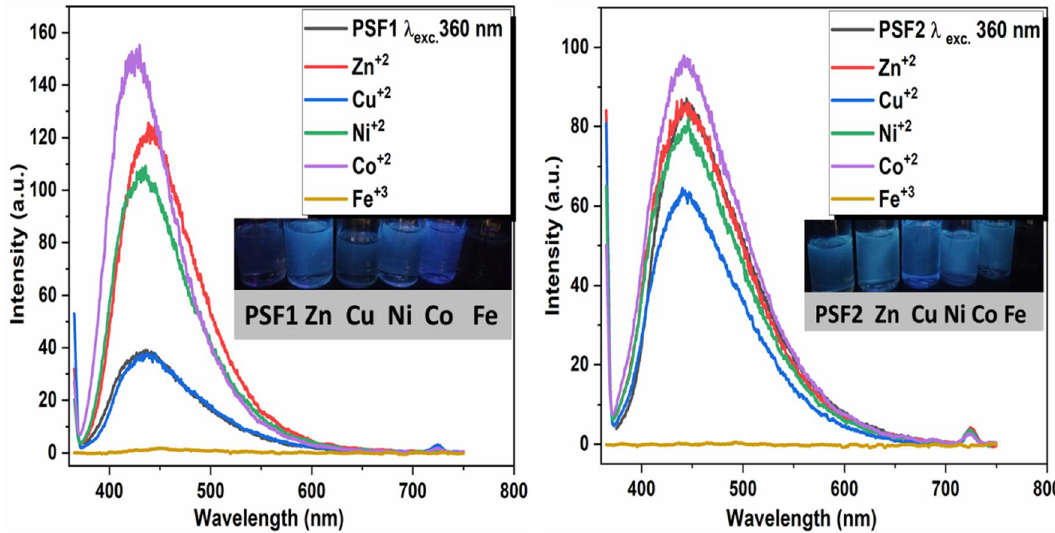
Figure 8. PL spectra of polymers and metals in DMSO with λ exc. 360 nm, inset images of polymers and their metals under UV lamp 365